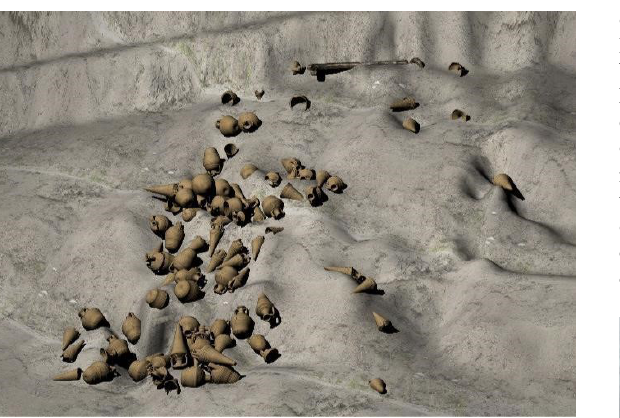
Figure 14. 2015 documentation: multi-image photogrammetry.